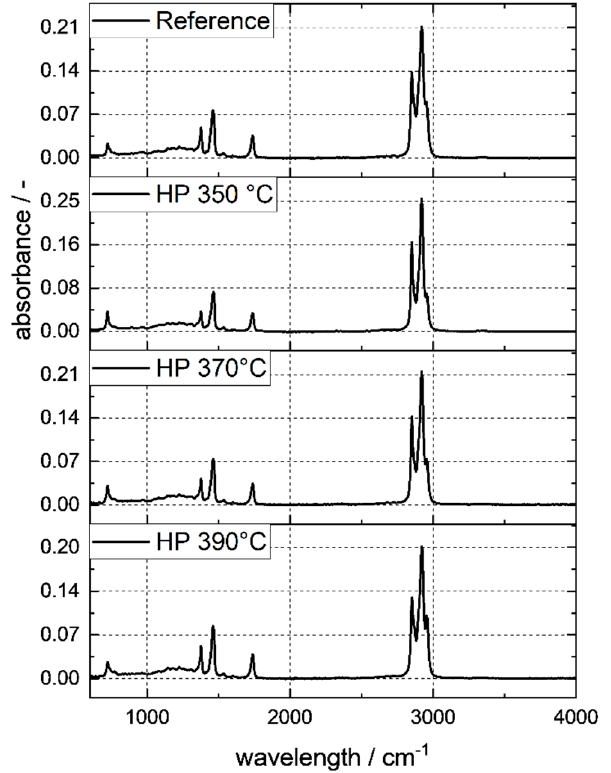
Figure 12. FTIR spectrograms of PW lubricants and pharmaceutical white oil (Reference: Paraffinum liquidum PH.EUR. 9.5, Caesar & Loretz GmbH, 40721 Hilden, Germany).